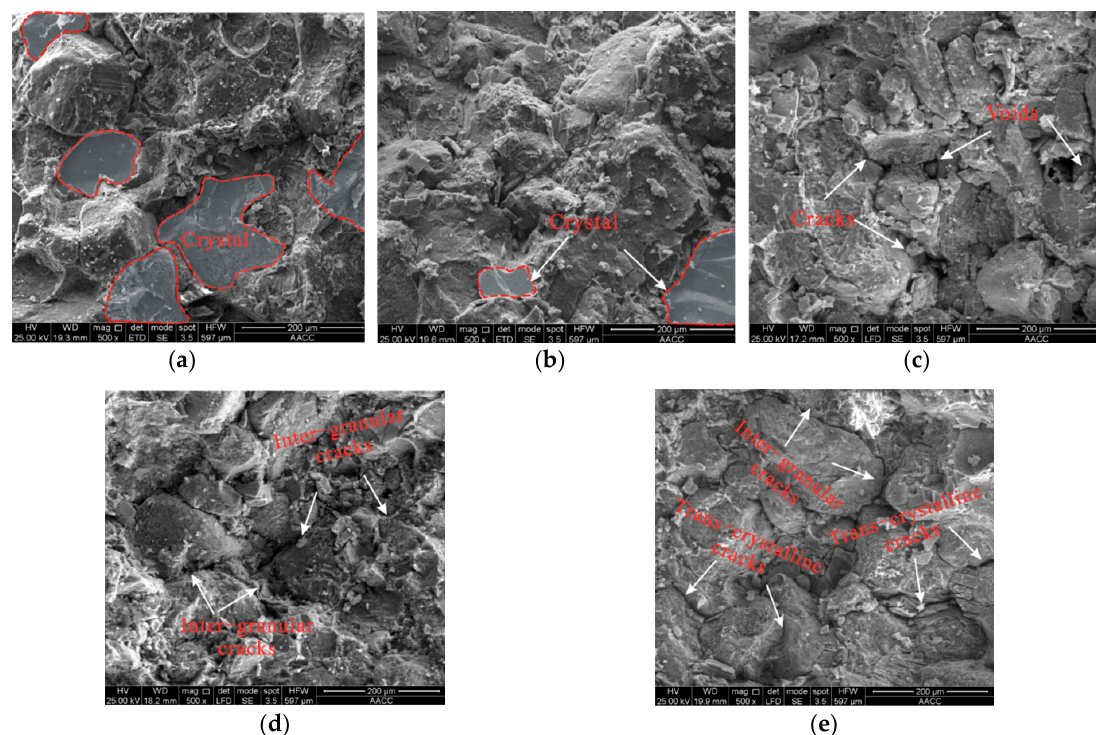
Figure 7. SEM images of sandstone samples after different temperature treatments. ( a ) 25 °C; ( b ) 200 °C; ( c ) 400 °C; ( d ) 600 °C; ( e ) 800 °C.